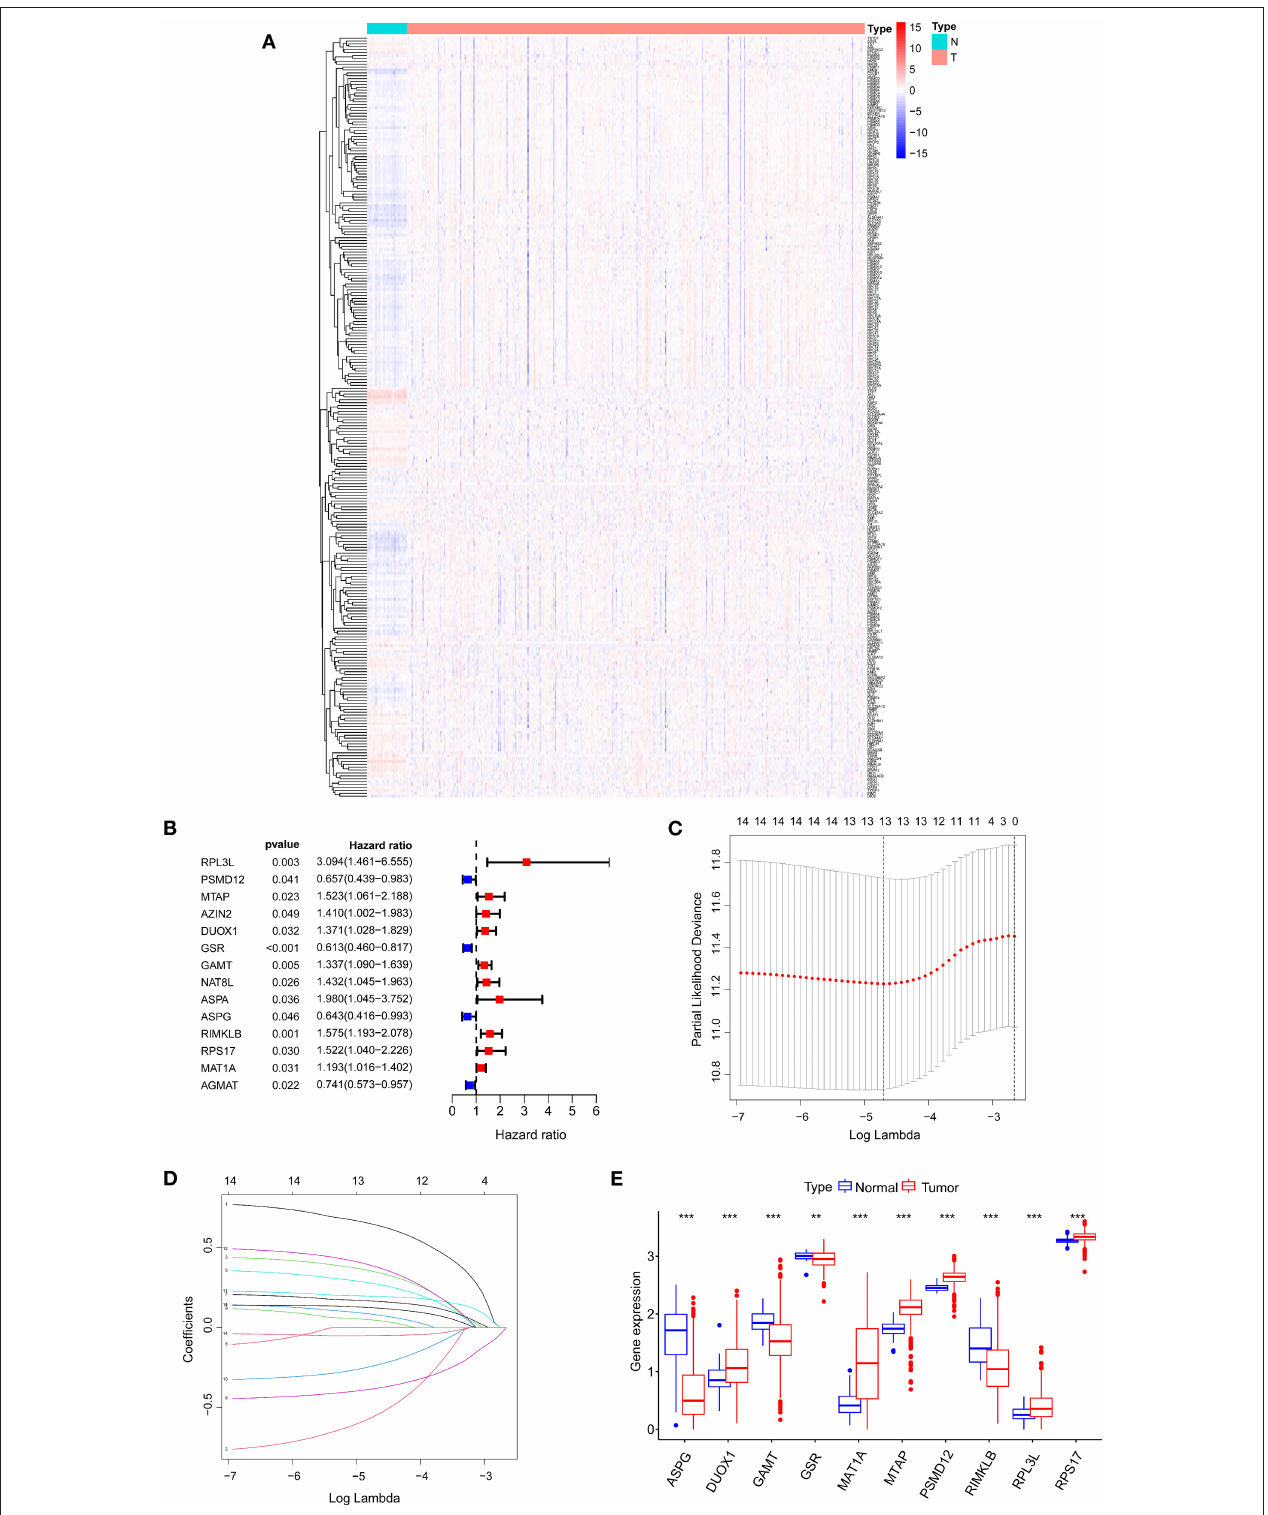
FIGURE 2 | Identifying candidate genes associated with the prognosis of COAD patients. (A) Differential expression heatmap of amino acid metabolism-related genes in COAD and normal tissues from the TCGA. (B) Univariate Cox regression analysis of AAMRGs. (C) Turning optimal parameter ( lambda ) screening in the LASSO model. (D) LASSO coefficient profiles of the prognostic genes. (E) Box plot of mRNA expression of AAMRGs. ** P < 0.01 and *** P < 0.001.